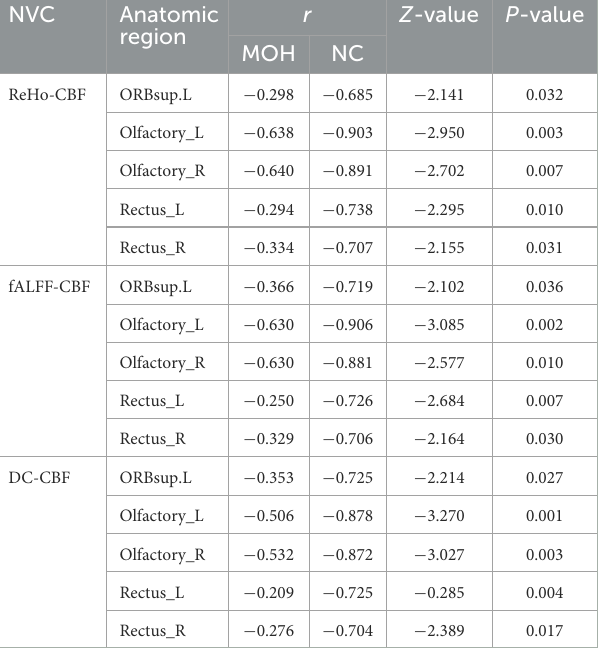
TABLE 2 Brain regions with altered NVC over the whole gray matter in